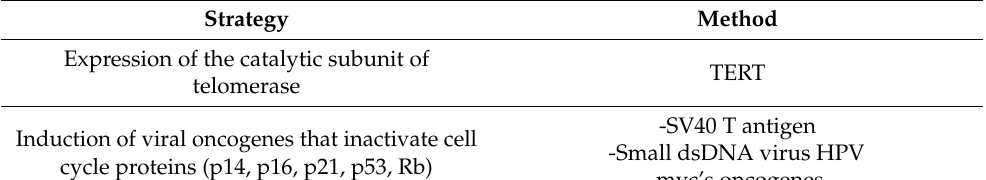
Table 2. Techniques for establishing in vitro cell immortalization.